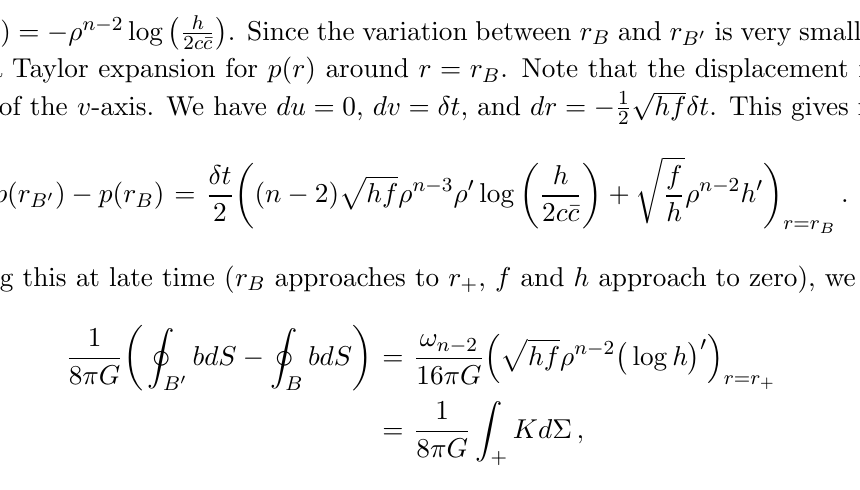
Figure 3 . The WDW patch of a charged AdS black hole with an inner horizon. The upper part of the patch runs into the inner horizon at late time, rather than a singularity. Thus, there are some new joints C ; C 0 which also contribute to the action